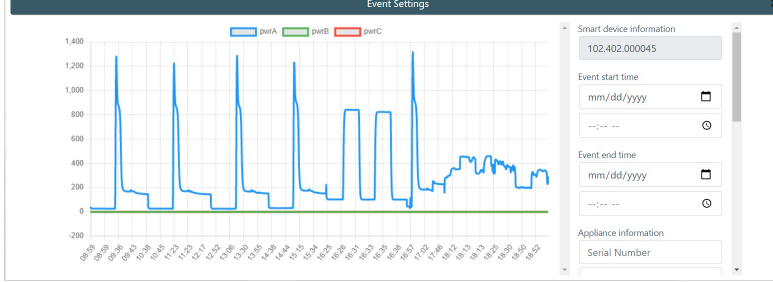
Figure 6. Historical data.